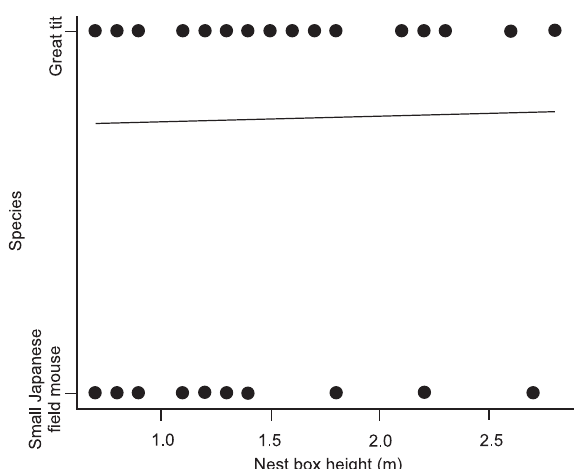
Figure 2. Plots of the height of nest boxes used by Parus major and Apodemus argenteus with a logistic regression